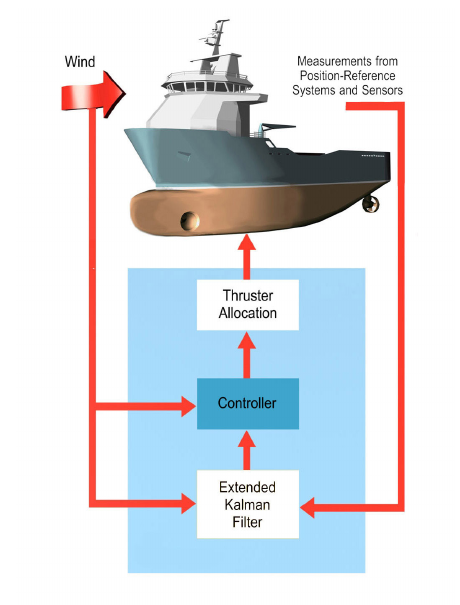
Figure 10: The control principle of a DP system. Mo- tion data are processed through a model- based Kalman filter to extract the slowly- varying components. By comparing this in- formation with the desired motion (feed- back), and also using the predicted wind effect on the vessel (feedforward), the con- troller gives commands to the propulsors on how they should behave in order for the ves- sel to keep its desired position and orienta- tion. Courtesy of Kongsberg